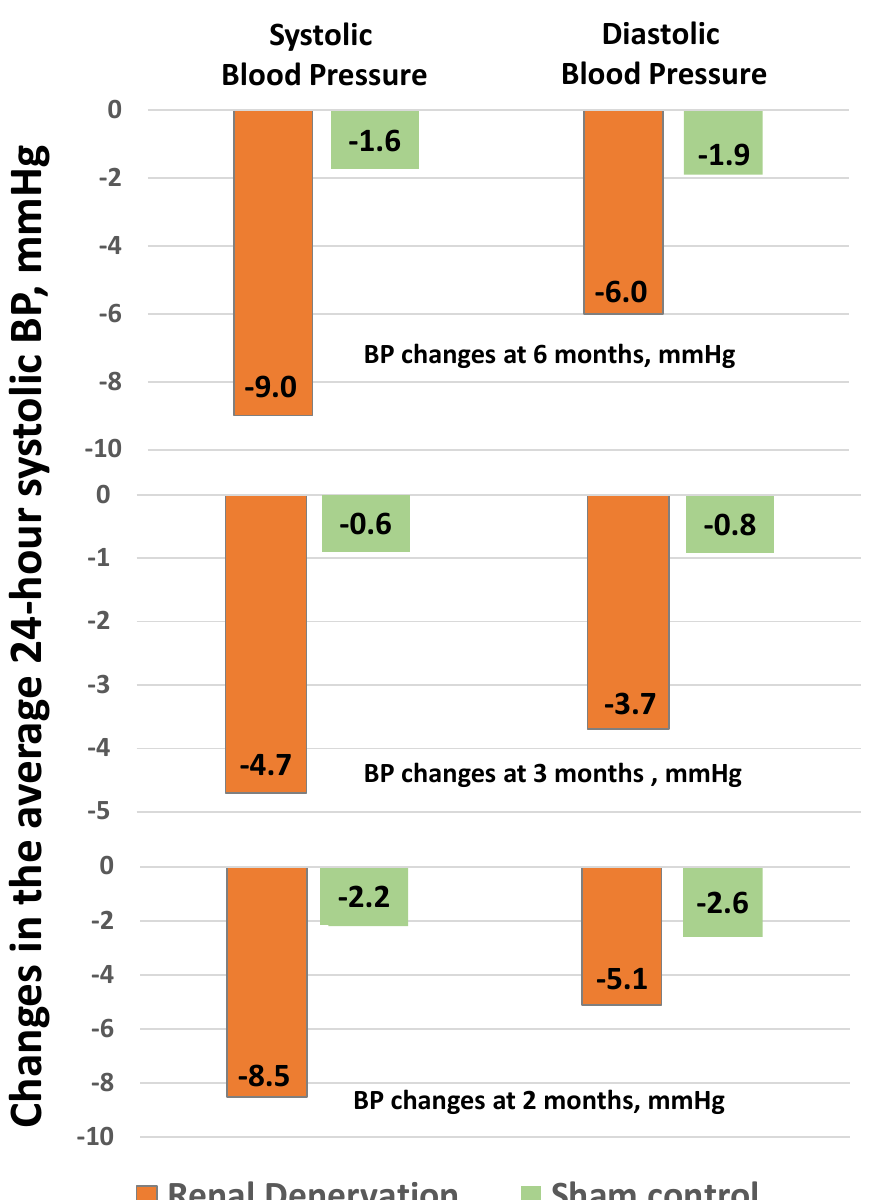
Figure 4. Changes in 24-h systolic BP at different time intervals in patients treated with renal denervation or sham control. Adapted from Azizi and coworkers [87], Bohm and coworkers [88] and Kandzari and coworkers [89].